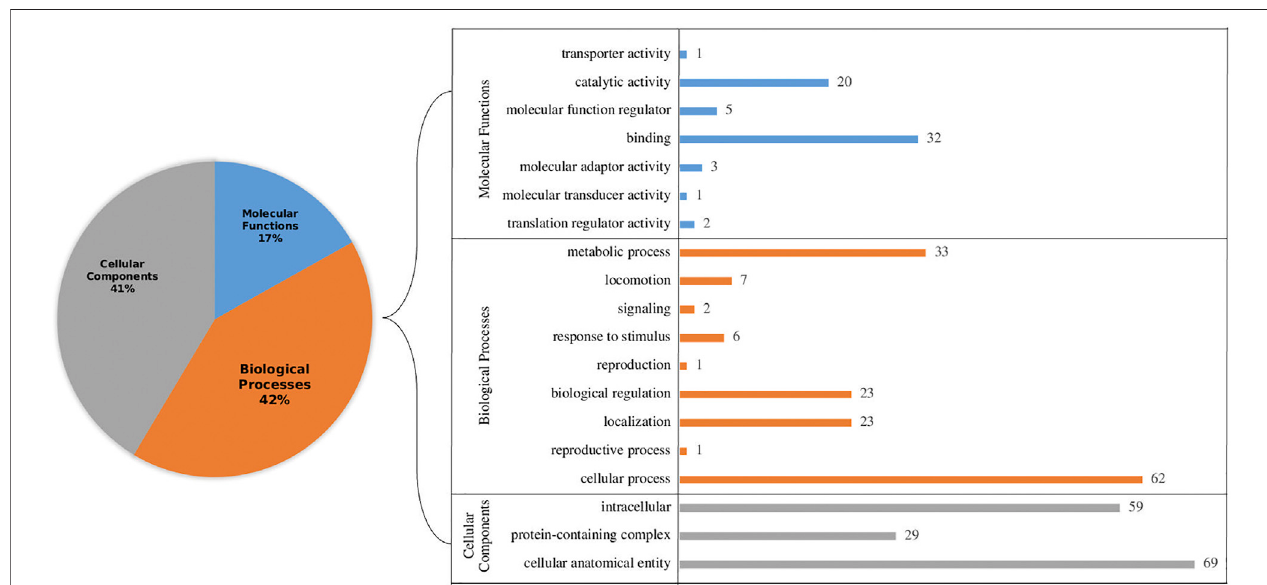
FIGURE 2 | Gene Ontology (GO) annotation of hypothetical proteins with functional signature sites present in the primary sequences to identify functional categories:cellularcomponents,biologicalprocessesandmolecularfunctionslevel.Theleftpanelshowsapiechartoftheoverallpercentage.Therightpanelshowsthe precise breakup of sub-components in each category.